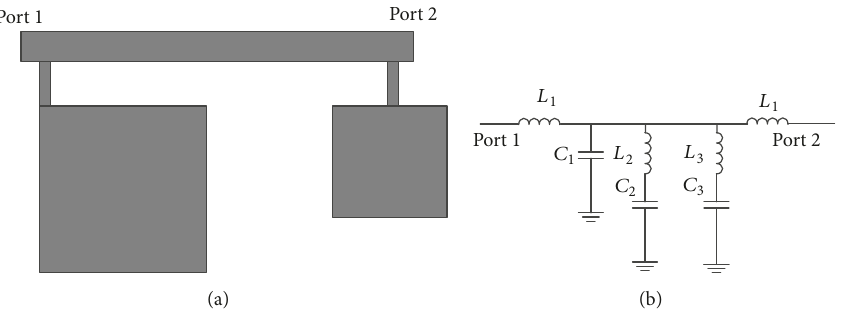
Figure 4: Transmission line with loading: (a) structure; (b) equivalent